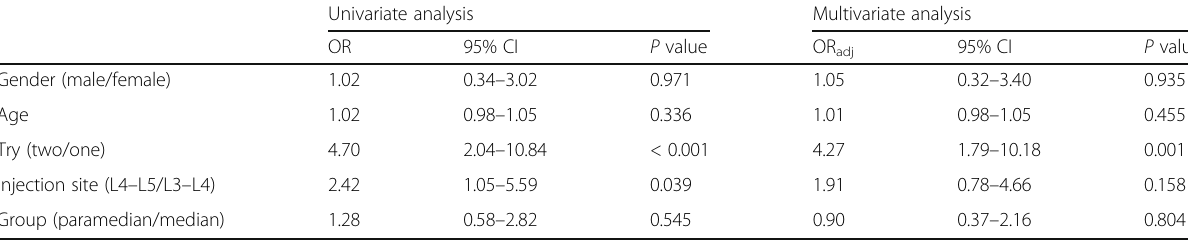
Table 4 Regression analysis and odds ratio (OR) of having low back pain at 24 h Univariate